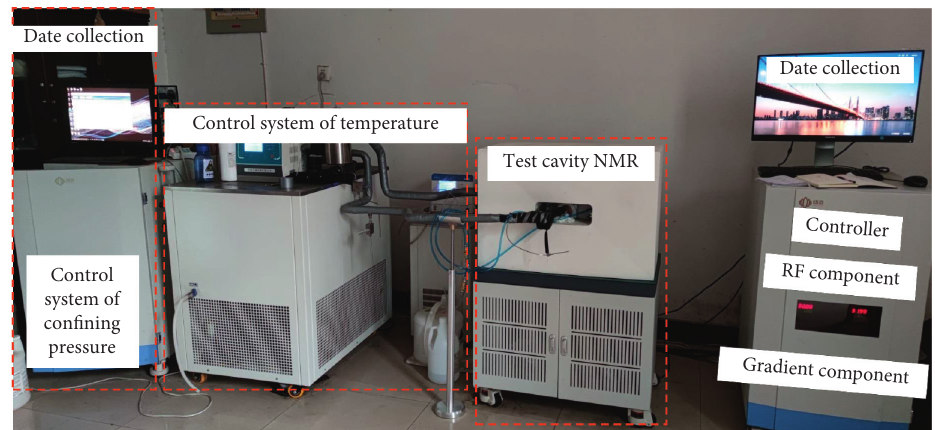
Figure 5: Low-field nuclear magnetic resonance test system (model MesoMR23-060V-I).